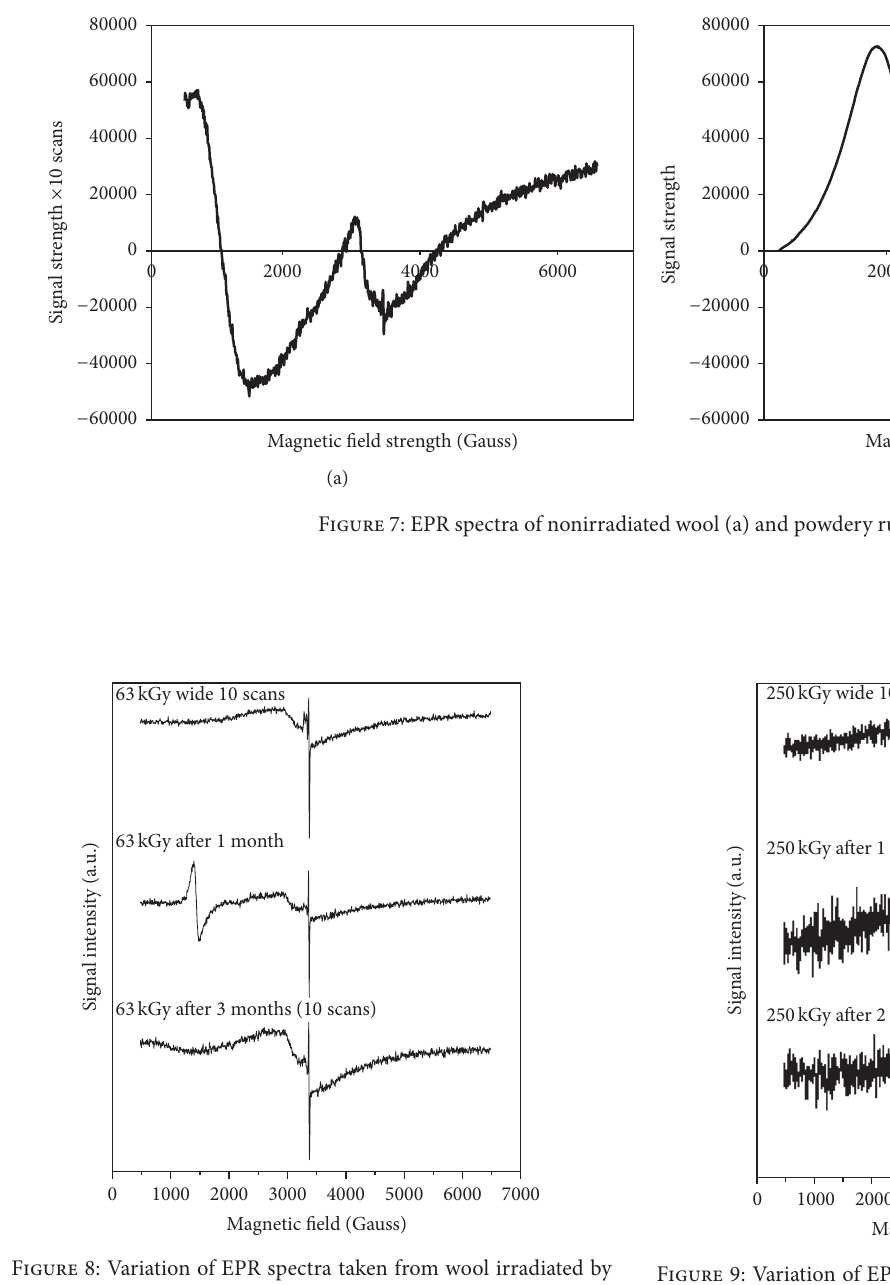
Figure 9: Variation of EPR spectra taken from wool irradiated by electron beam (250kGy) and measured within time interval from the exposure: 7 days, 1 month, and 2 months; measuring conditions as mentioned in Figure